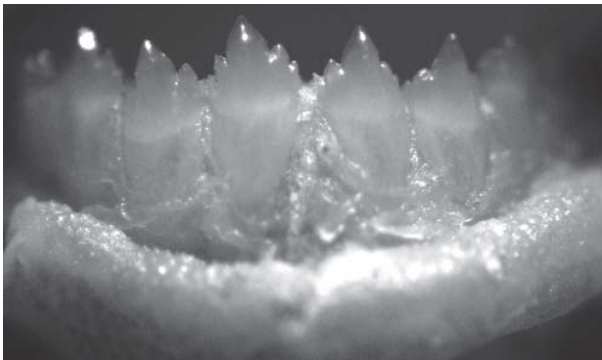
Fig. 7. Frontal view of dentary teeth of Astyanax sp. aff.